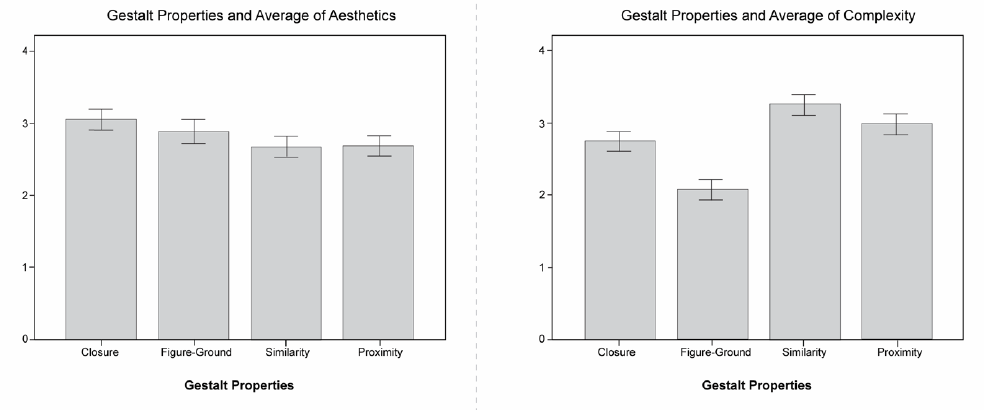
Figure 10. The aesthetic and complexity score of different gestalt properties. Photos of similarity are most complex and have the lowest aesthetic